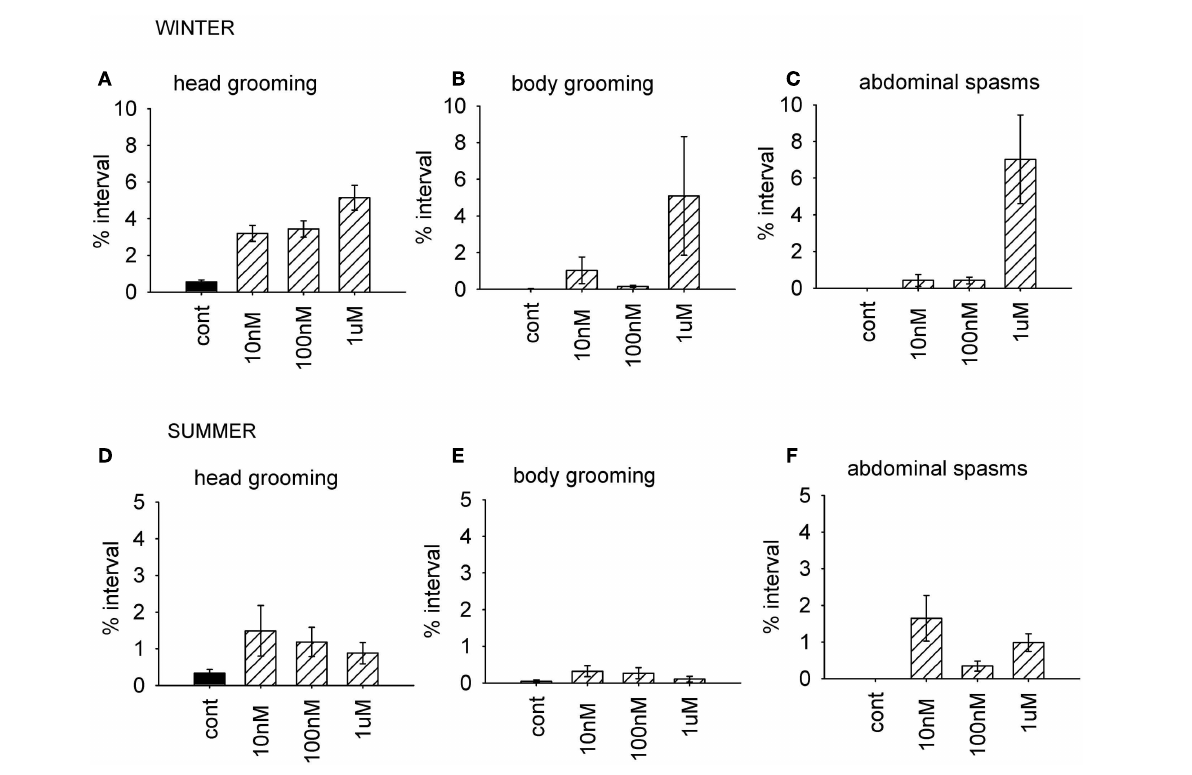
FIGURE 4 |Time budget data for bees treated with different doses of coumaphos. Mean percentage of the observation interval ( ± SEM) spent engaged in the behaviors comprising the behavioral component which was differentially affected by the drugs according to the time of year. (A) Head